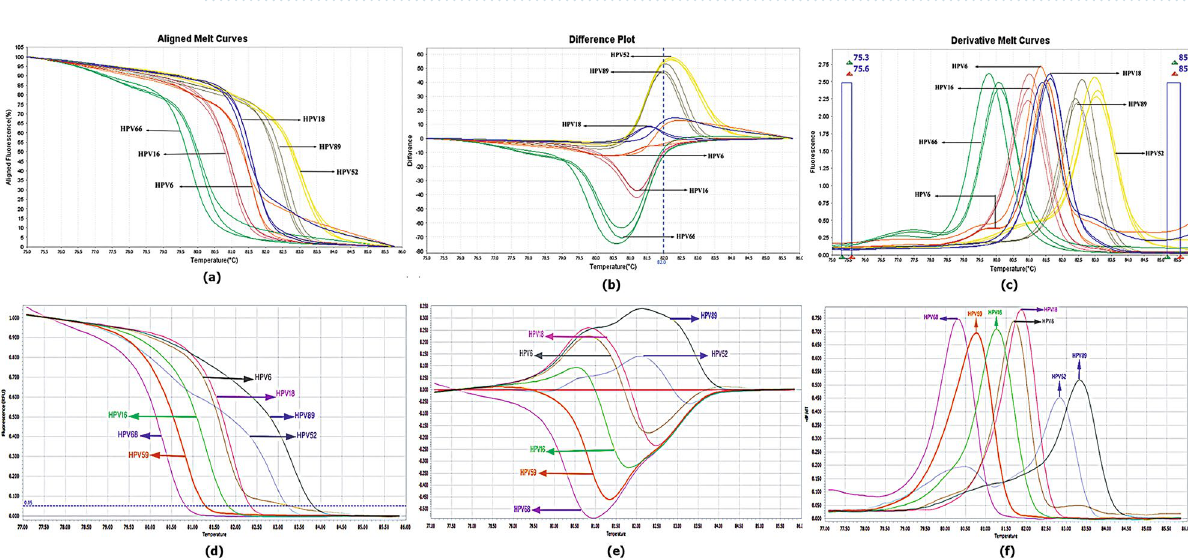
Figure 2. Real-time PCR of the L 1 amplicon of HPV 6, 16, 18, 52, 59, 66, 89 using the primers FRG5 and FRG2. Aligned melt curves, difference plot, and derivative melt curve on StepOnePlus real-time PCR system receptivity ( a , b , c ). Aligned melt curves, difference plot, and derivative melt curve on a LightCycler 96 machine, receptivity ( d , e , f